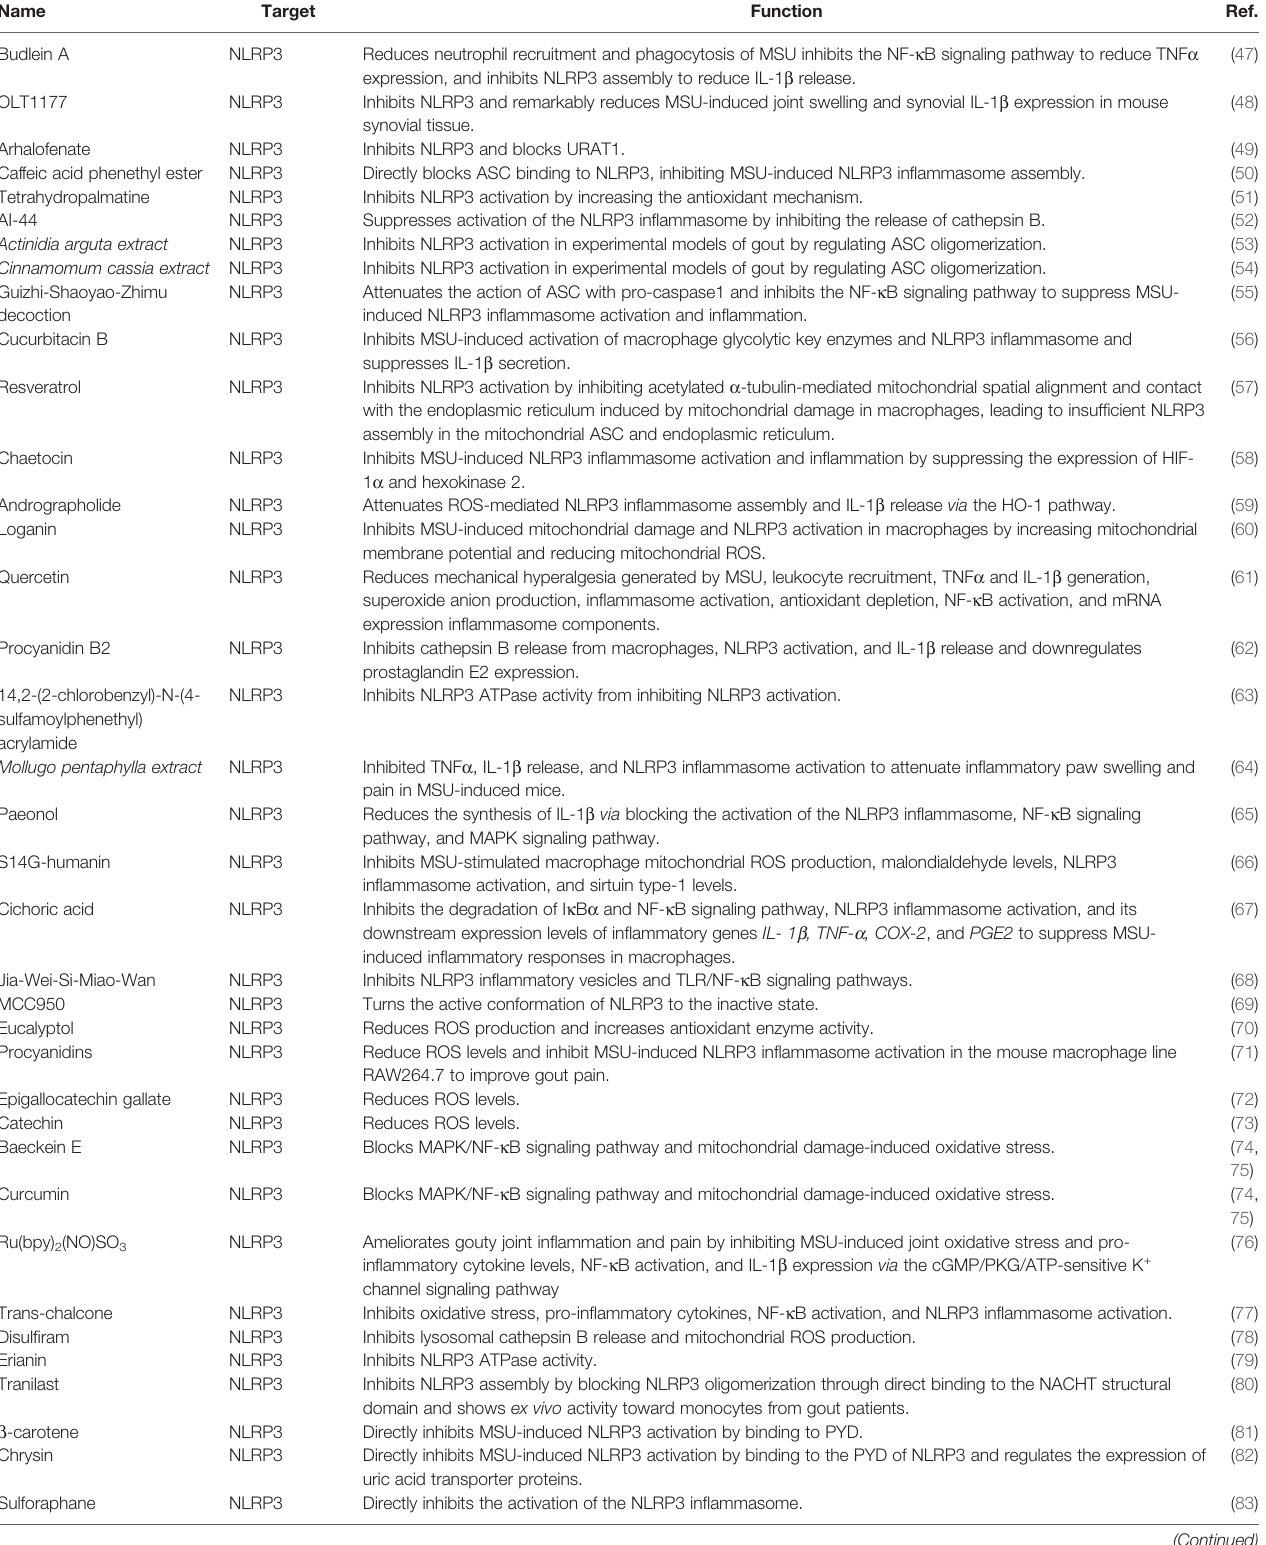
TABLE 1 | Multiple potential compounds targeting cell death for the treatment of gout.